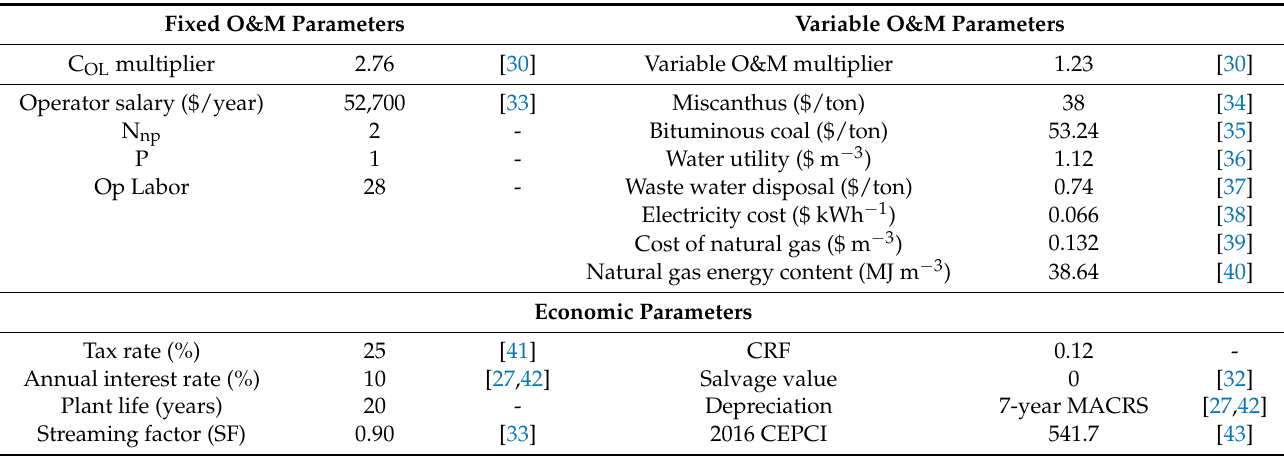
Table 3. Fixed and variable operating and maintenance (O&M) parameters and economic parameters used for estimating operating labor and costs associated with